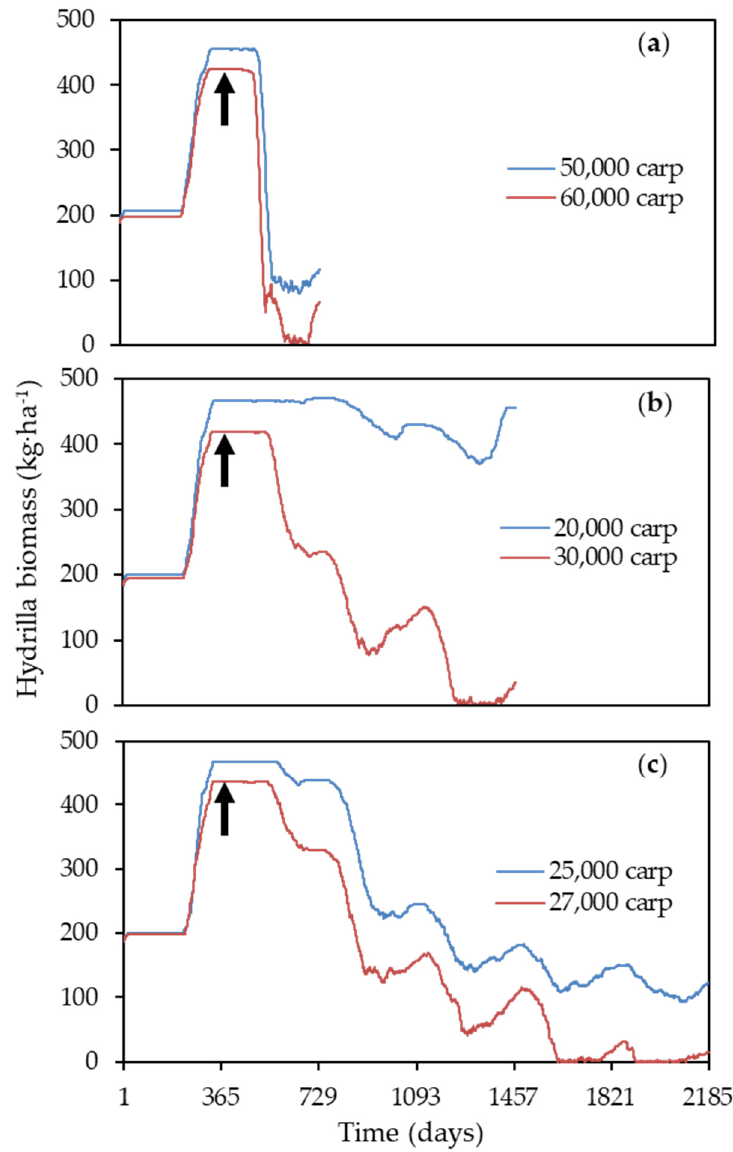
Figure 8. Number of simulated grass carp needed to eradicate Hydrilla within ( a ) one, ( b ) three, or ( c ) five years after Hydrilla invasion, assuming stocking occurred one year after invasion. Black arrows denote when grass carp were stocked.